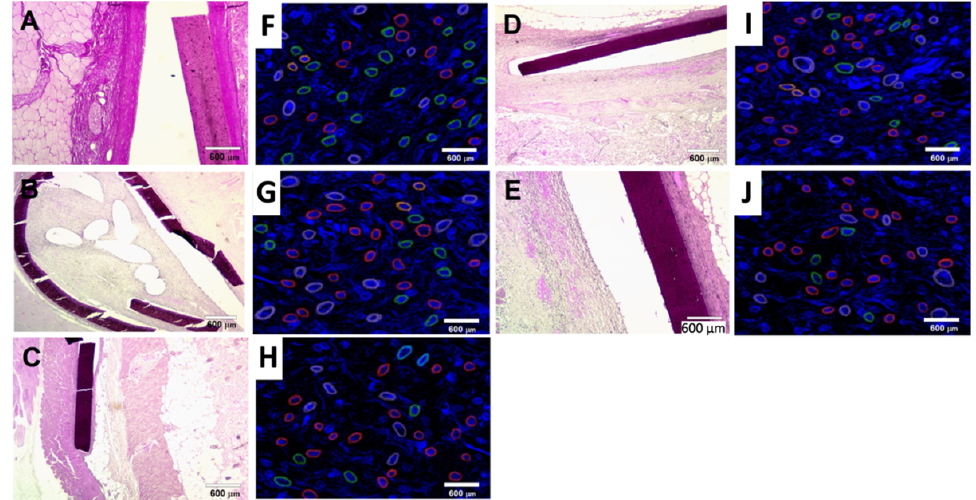
Figure 7. Histological study and results of an immunofluorescent study of the films following 30 days of subcutaneous implantation in rats under hematoxylin-eosin staining: ( А ) CS; ( В ) CS-Plu-G 1%; ( С ) CS-Plu-G 3%; ( D ) CS-PVP-G 1%; ( E ) CS-PVP-G 3%. Chemical modification of the films by graphene and stabilizers reduces the risk of implant destruction and inhibit leukocyte infiltration. Results of an immunofluorescent study of CD4+ marker expression for CD4+ T-lymphocytes (red), CD8+ for CD8+ T-lymphocytes (green), CD68 for macrophages (pink), CD20 for B lymphocytes (orange) and CD138 for plasma cells (blue) in CS ( F ), CS-Plu-G 1% ( G ), CS-Plu-G 3% ( H ), CS-PVP-G 1% ( I ) and CS-PVP-G 3% ( J ) groups. Chemical modification of the films by graphene and stabilizers has led to decrease in the pro-inflammatory lymphocytes and an increase in the anti-inflammatory lymphocytes. The scale bar represents 600 μm.